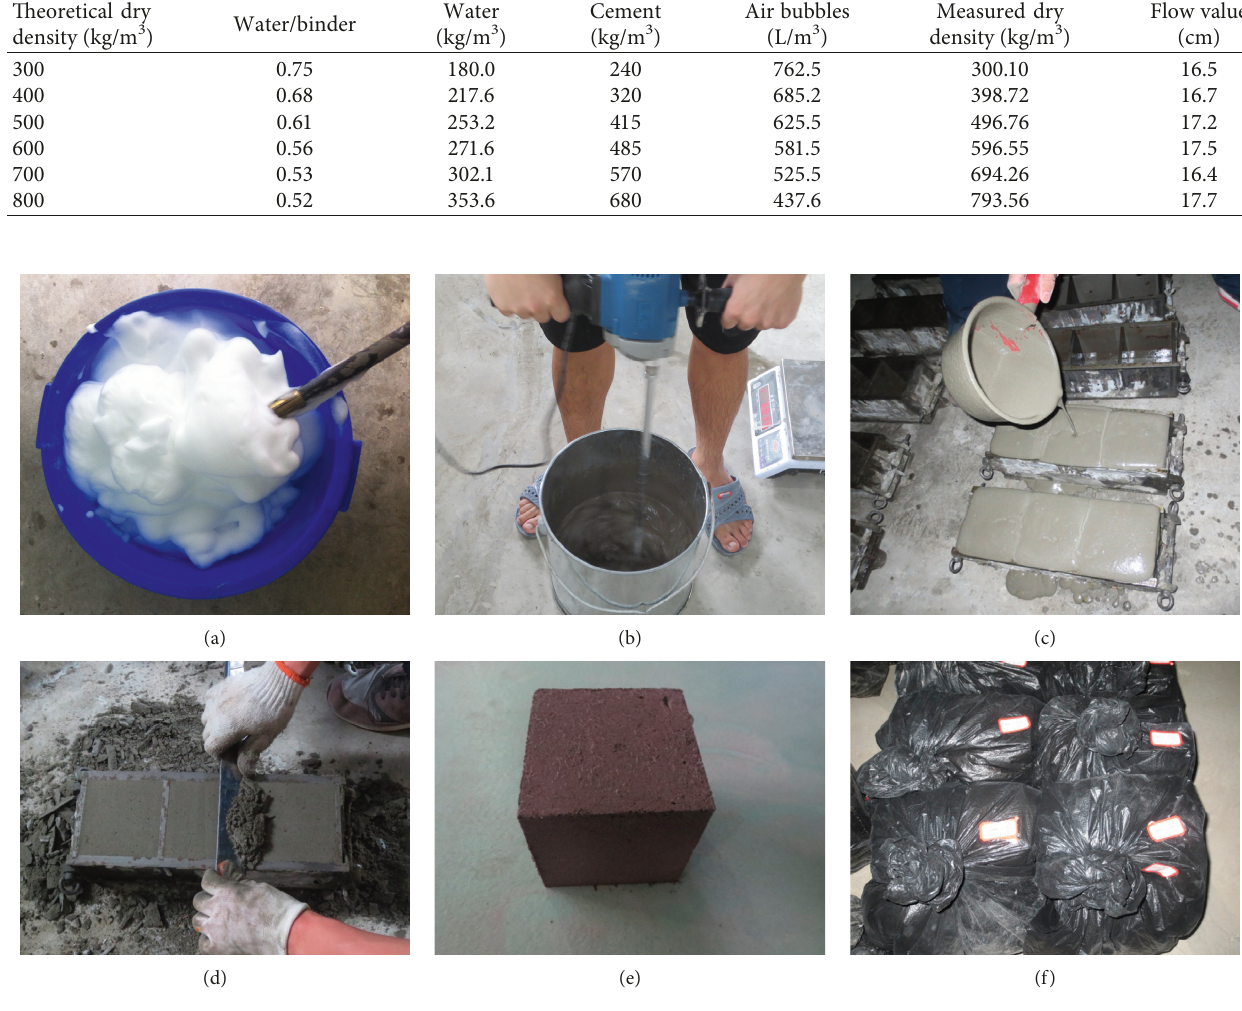
Figure 1: The process of the specimen preparation.